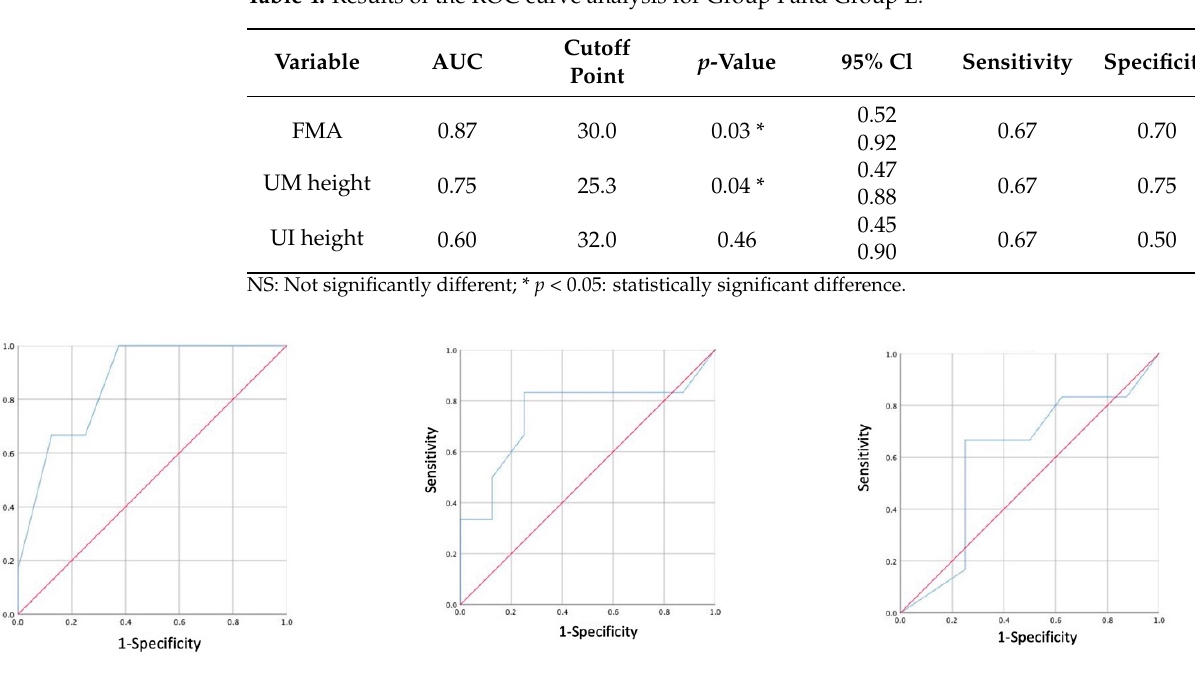
Table 4. Results of the ROC curve analysis for Group I and Group E.